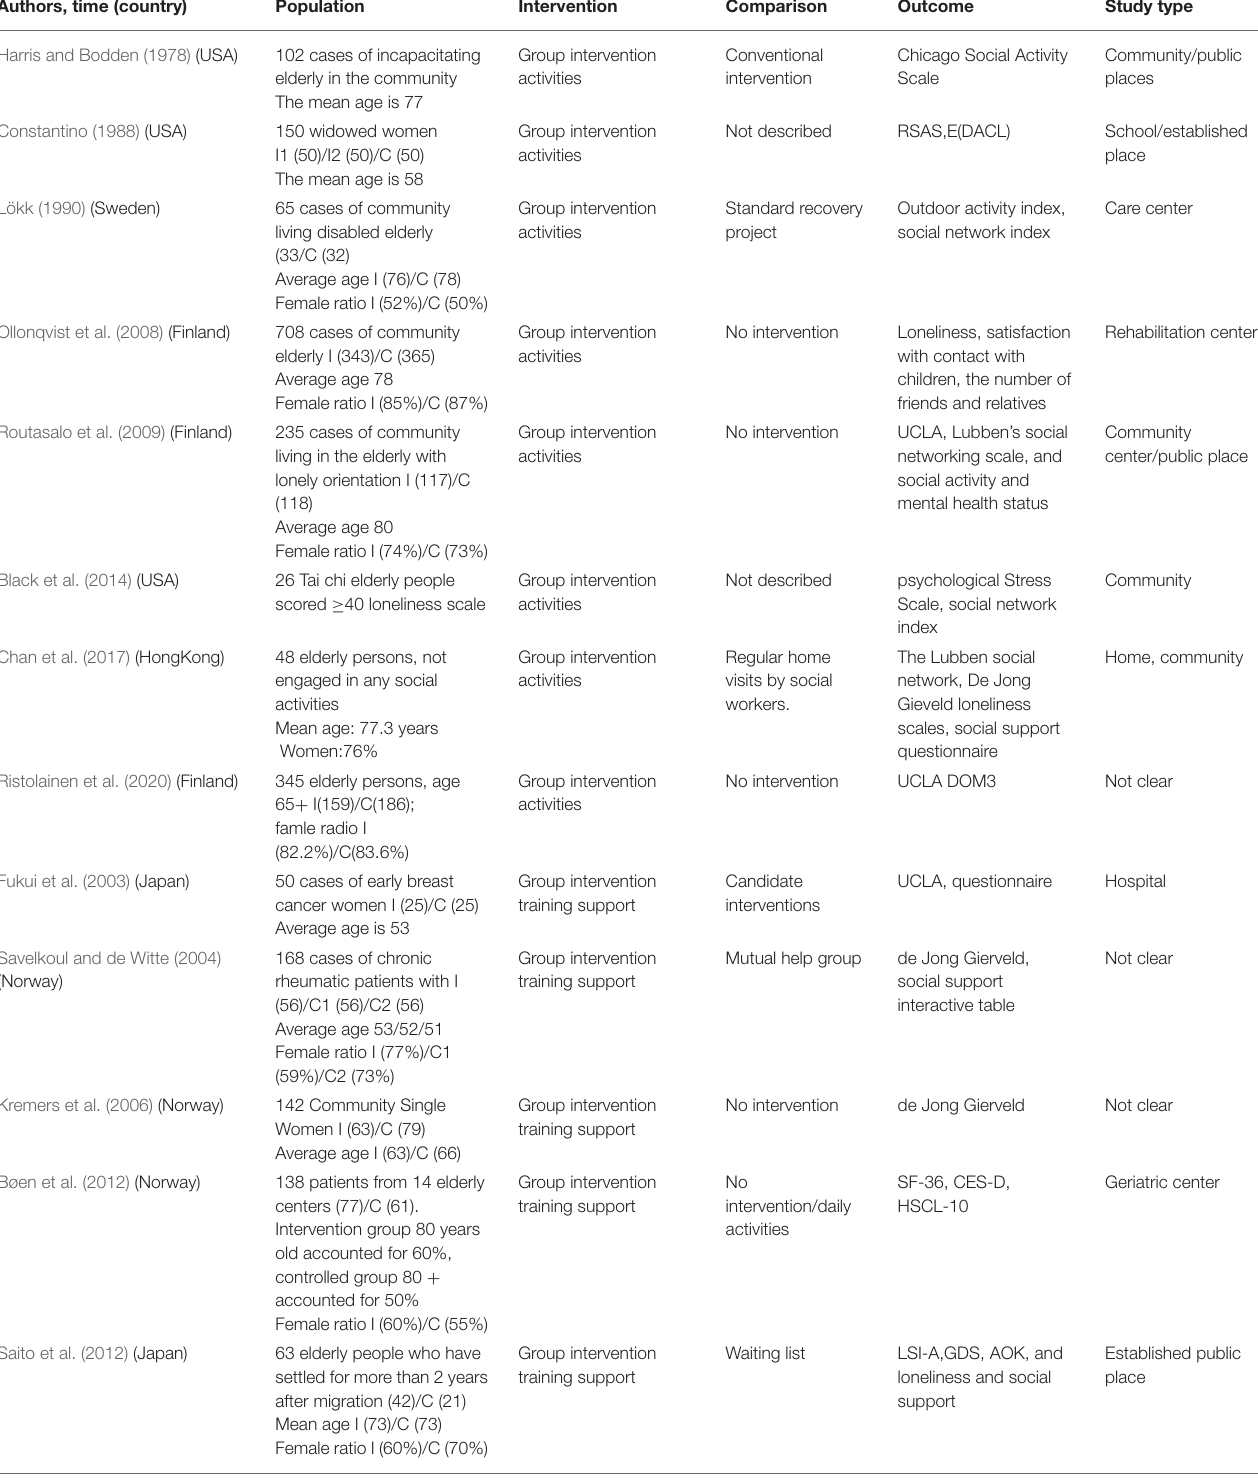
TABLE 1 | Characteristics of studies stratified by